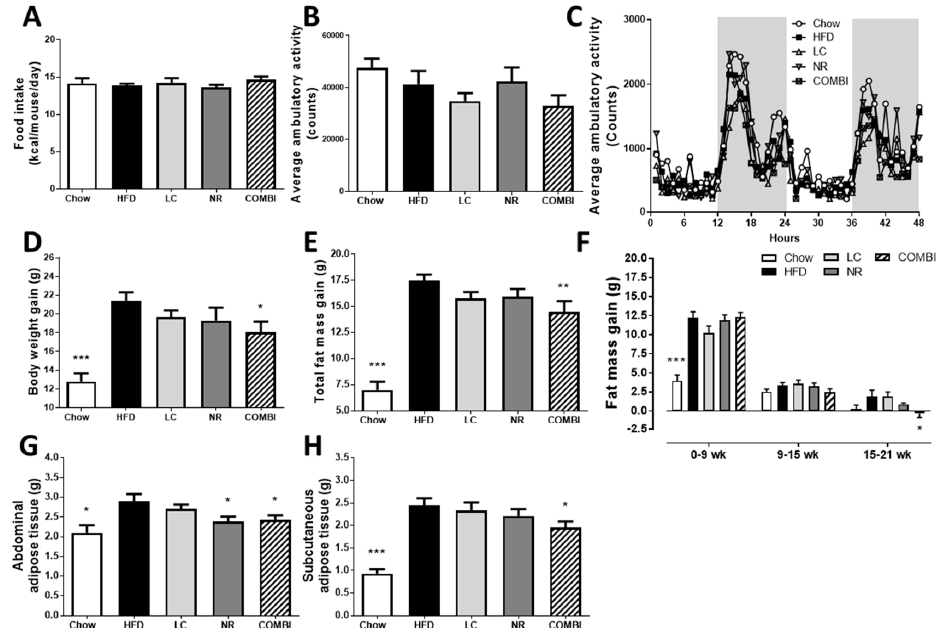
Figure 2. E ff ect of LC, NR and COMBI treatment on obesity after 21 weeks of treatment. ( A ) Food intake, ( B ) average ambulatory activity represented in counts, i.e., amount of infrared beam interruptions caused by movement, ( C ) average ambulatory activity during 48 hours, ( D ) body weight gain, ( E ) total fat mass gain, ( F ) fat mass gain over time, ( G ) abdominal tissue mass and ( H ) subcutaneous adipose tissue mass. Data are presented as mean ± SEM, * p < 0.05 or ** p < 0.01 or *** p < 0.001 compared to the HFD control group.